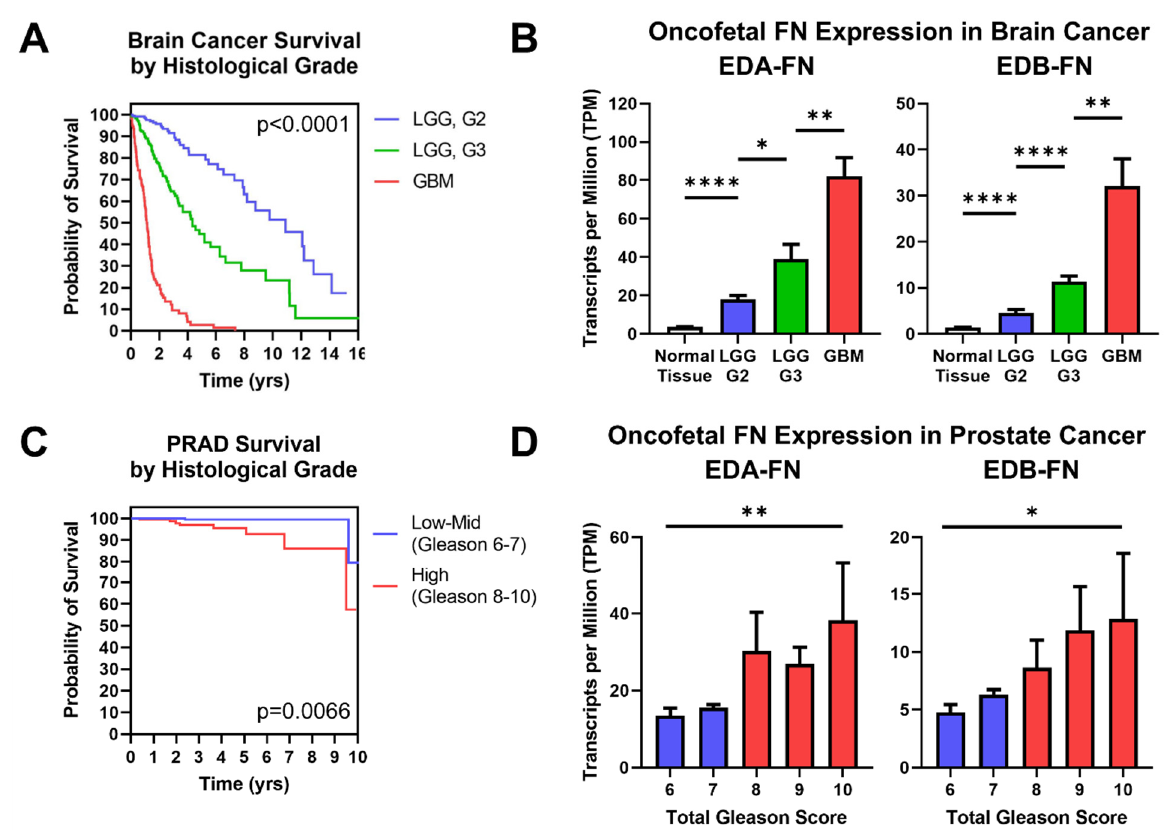
Figure 7. Oncofetal FN expression and histological grade. ( A ) Kaplan–Meier survival curves for brain cancers separated out by histological grade (LGG G2, n = 247; LGG G3, n = 260; GBM, n = 152). The colors of the curves correspond to the column graphs in ( B ). ( B ) Oncofetal fibronectin expression in brain cancers and corresponding normal tissue ( n = 1152), separated out by histological grade (LGG G2, n = 247; LGG G3, n = 260; GBM, n = 152). Glioblastoma multiforme was considered the highest grade of brain cancer. ( C ) Kaplan–Meier survival curves for prostate cancer of low–mid grade (Gleason score 6–7; n = 271) and high grade (Gleason score 8–10; n = 191). Groups were combined for sample size purposes. The colors of the curves correspond to the column graphs in ( D ). ( D ) EDB-FN expression in prostate cancer separated out by total Gleason score (6, n = 43; 7, n = 228; 8, n = 57; 9, n = 131; 10, n = 4). Statistical analysis for prostate cancer data used the Kruskal–Wallis